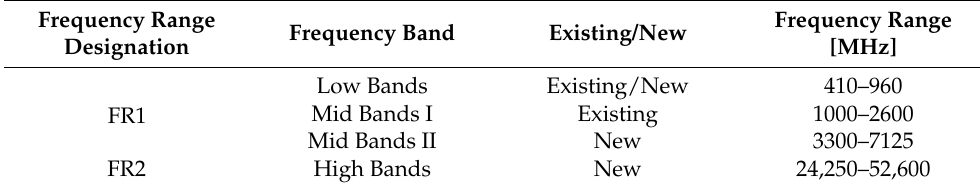
Table 1. Overview of 5G frequency ranges and bands